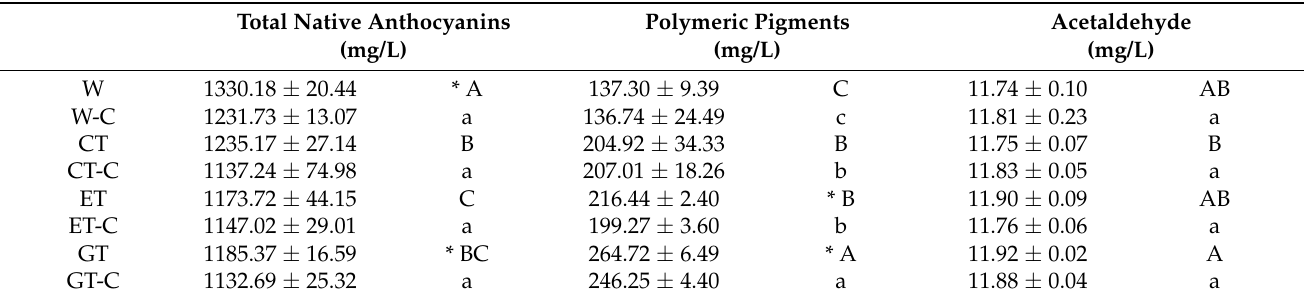
Table 1. Effect of tannins and C on total anthocyanin, polymeric pigments, and acetaldehyde determined by HPLC